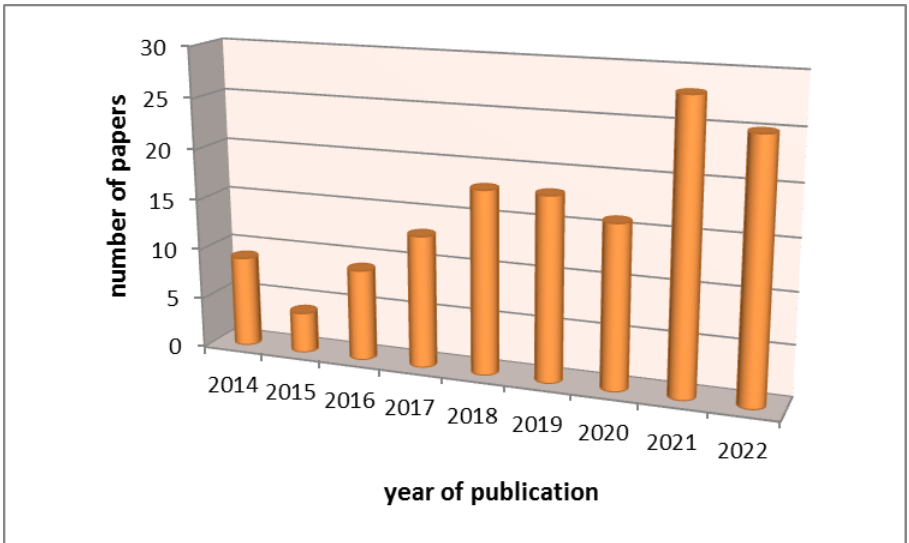
Figure 1. The number of published papers dealing with electrochemical sensors for the determina- tion of caffeine from 2014 to 2022 based on Scopus database. of caffeine from 2014 to 2022 based on Scopus